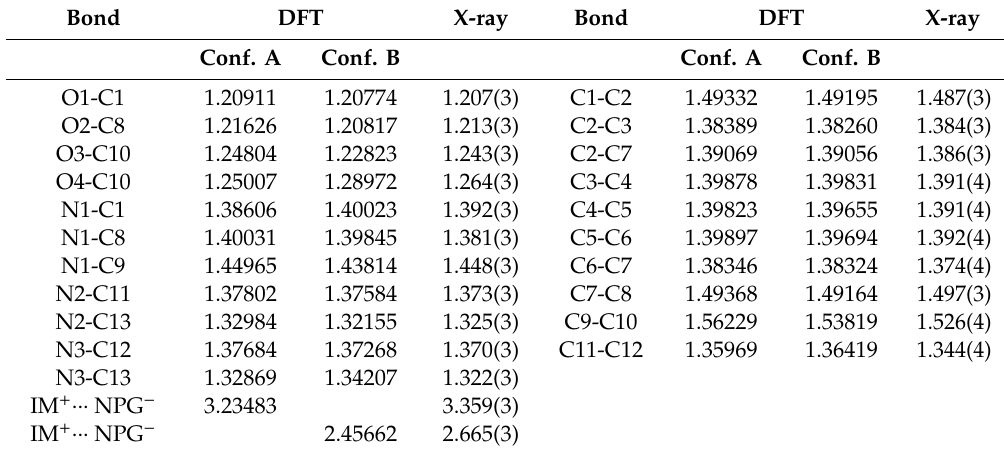
Figure 3. Crystal structure with the label of IM + –NPG − –HYD . Table 2. Single-crystal X-ray determined, and DFT calculated bond Lengths in Å for IM + -NPG − -HYD.